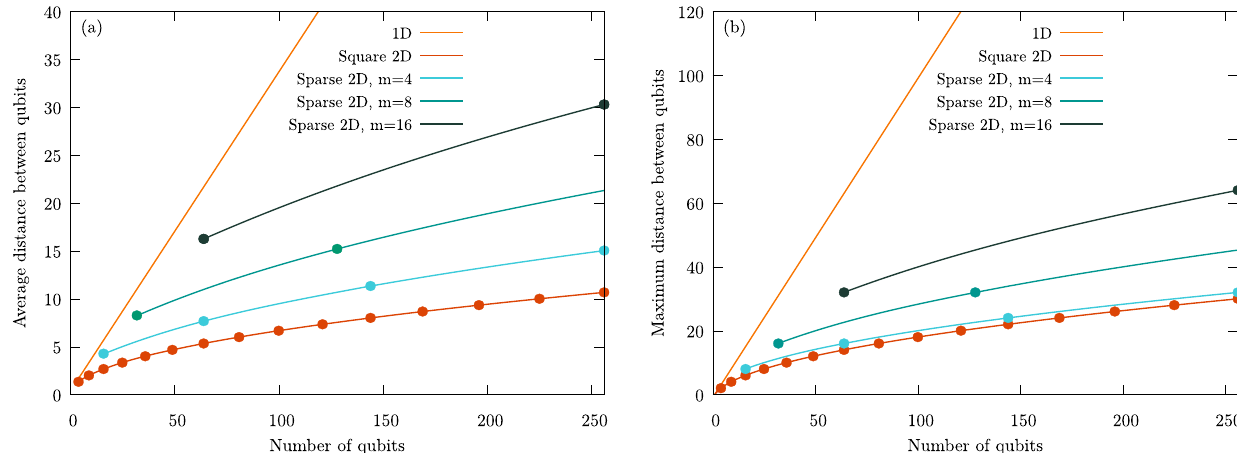
Fig. 5 Compilation overhead of Case I. This is expressed via a average and b maximum shortest path as a function of the number of qubits for different layouts — a (1D) linear layout, a (2D) rectangular device with nearest neighbor connectivity with l x = l y and the proposed architecture in a square arrangement d x = d y with m = 4, 8, and 16. Lines indicate the scaling and dots indicate qubit numbers which can be realized by an actual device.